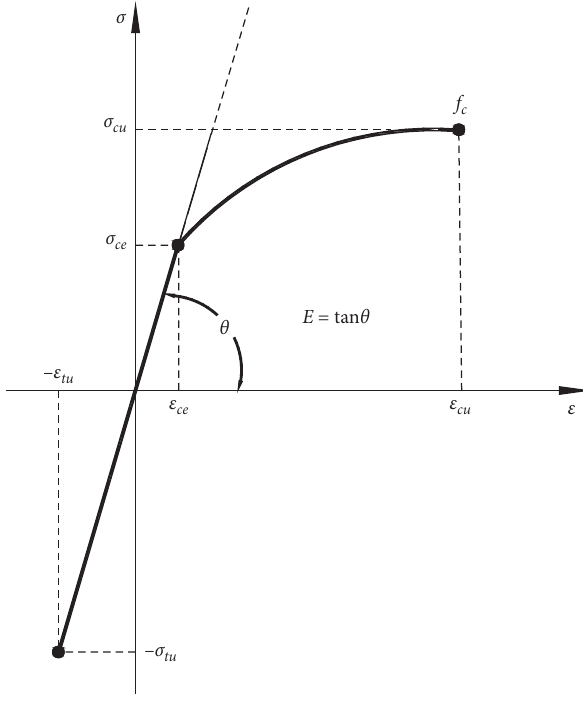
Figure 2: Uniaxial stress-strain